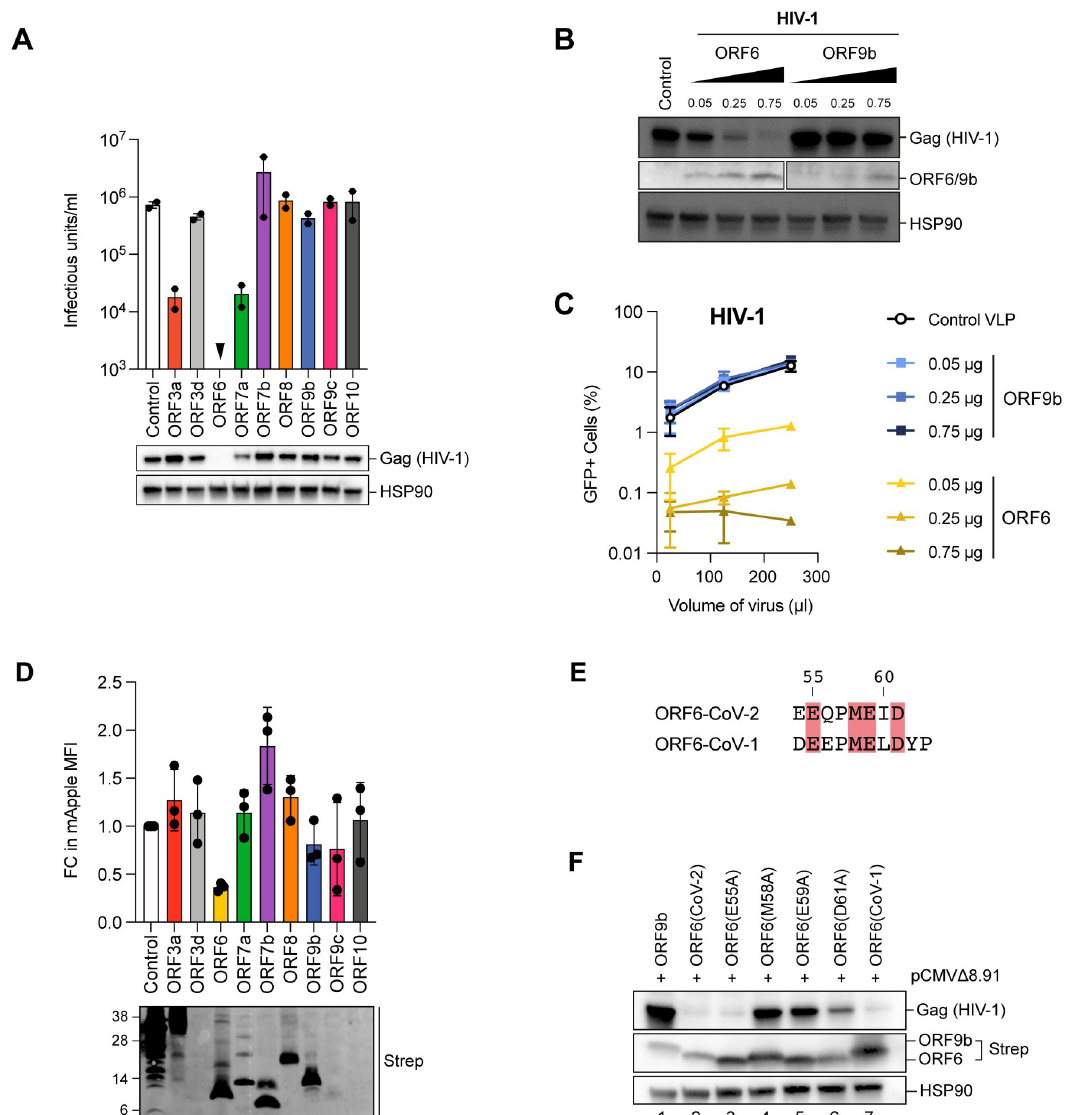
Fig 1. SARS-CoV-2 ORF6 inhibits protein expression. (A) To generate VLPs, HEK293T cells were co-transfected with plasmids encoding HIV-1 Gag-Pol, VSV-G and a pLVX-StrepII-ORF vector encoding either SARS-CoV-2 ORF3a, ORF3d, ORF6, ORF7a, ORF7b, ORF8, ORF9b, ORF9c or ORF10 or an empty vector control. VLPs were harvested and titrated in HeLa cells. The infectious units/ml are shown in the bar graph. Points indicated independent biological repeats. Transfected cell lysates were separated by SDS-PAGE and analysed for Gag(HIV-1) and HSP90 by immunoblotting. (B,C) HEK293T cells were transfected with plasmids encoding HIV-1 Gag-Pol, VSV-G and either increasing amounts of pLVX-StrepII-ORF6 or pLVX-StrepII-ORF9b as well as a GFP reporter plasmid, pCSGW. (B) Transfected cell lysates were separated by SDS-PAGE and analysed for Gag(HIV-1), ORF6 or ORF9b and HSP90 by immunoblotting. (C) HeLa cells were infected with increasing amounts of HIV-1 VLPs. Three days post infection, the percentage of GFP positive cells was determined by flow cytometry. Graph shows the mean and range of two biological repeats. (D) HEK293T cells were transfected with the pLVX-EF1 α plasmid encoding strep-tagged GFP(Control), ORF3a, ORF3d, ORF6, ORF7a, ORF7b, ORF8, ORF9b, ORF9c or ORF10 and a plasmid encoding mApple. After 48h, cells were fixed and the mApple median fluorescent intensity (MFI) measured by flow cytometry. The fold change (FC) in MFI is plotted relative to the control for independent biological repeats. Error bars show SEM. Transfected cell lysates were analysed by SDS-PAGE and immunoblotting with anti-strep. (E) Amino acid alignment of the C-terminus region of ORF6 from SARS-CoV-2 and SARS-CoV-1 with conserved residues highlighted in red. (F) HEK293T cells were transfected with pLVX-EF1 α encoding strep-tagged ORF9b, ORF6(CoV-2), ORF6(CoV-1) or indicated ORF6(CoV-2) mutant and a plasmid encoding HIV-1 Gag-Pol. After 24h, cell lysates were separated by SDS-PAGE and analysed for Gag(HIV-1), Strep and HSP90 by immunoblotting.